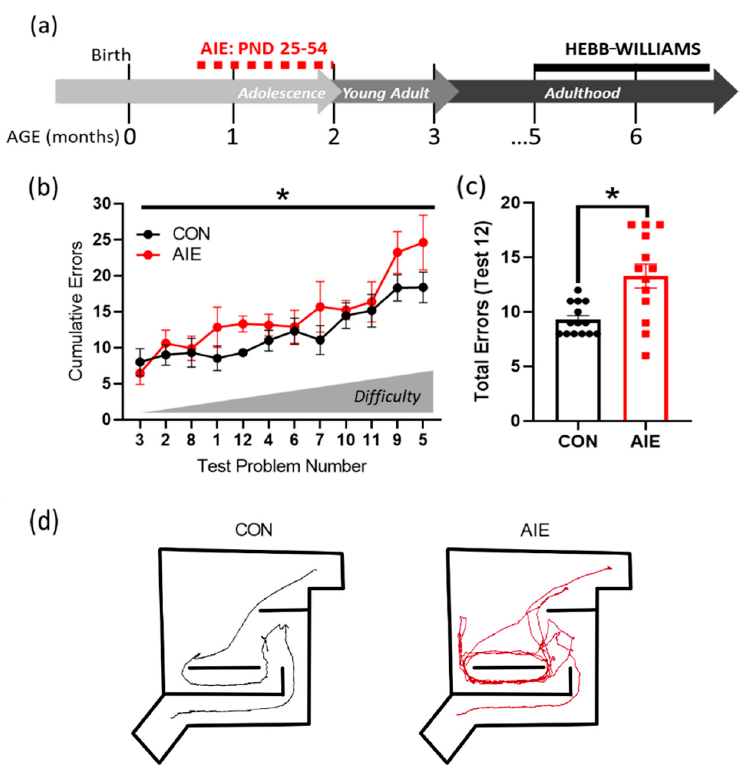
Figure 4. AIE increases errors in the Hebb-Williams maze battery. ( a ) Timeline of Hebb–Williams testing paradigm. Rats underwent AIE or CON gavage paradigms from PND 25–54. The Hebb-Williams maze was conducted later in adulthood (5–6 months of age). Males were tested first, followed by females. ( b ) As shown, tests were ranked by di ffi culty. In general, AIE increased errors in the Hebb-Williams maze, with greater divergence evident with increasing di ffi culty. ( c ) An example distribution of the number of errors rats made on test 12. AIE significantly increased the number of cumulative errors across the eight trials. ( d ) Example runs taken from test 12 for control (left) and AIE (right). Controls, on average, did not repeat errors, unlike AIE rats, which perseverated on the same incorrect turns. Results are expressed as mean ± SEM. * p < 0.05.